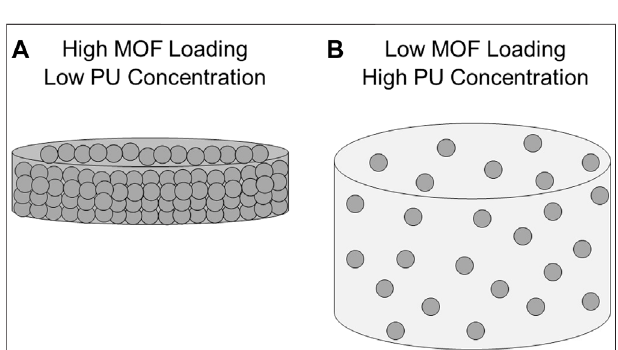
FIGURE 4 | Hypothesized models of MOF composite NO generation. (A) High MOF loading, low PU concentration composites experience crowding in which MOF agglomerations or layers reduce total MOF surface area available for catalysis. (B) Low MOF loading, high PU concentration composites reduce analyte diffusiondeep intocenterof fi lmlimiting number of accessible MOF particles for